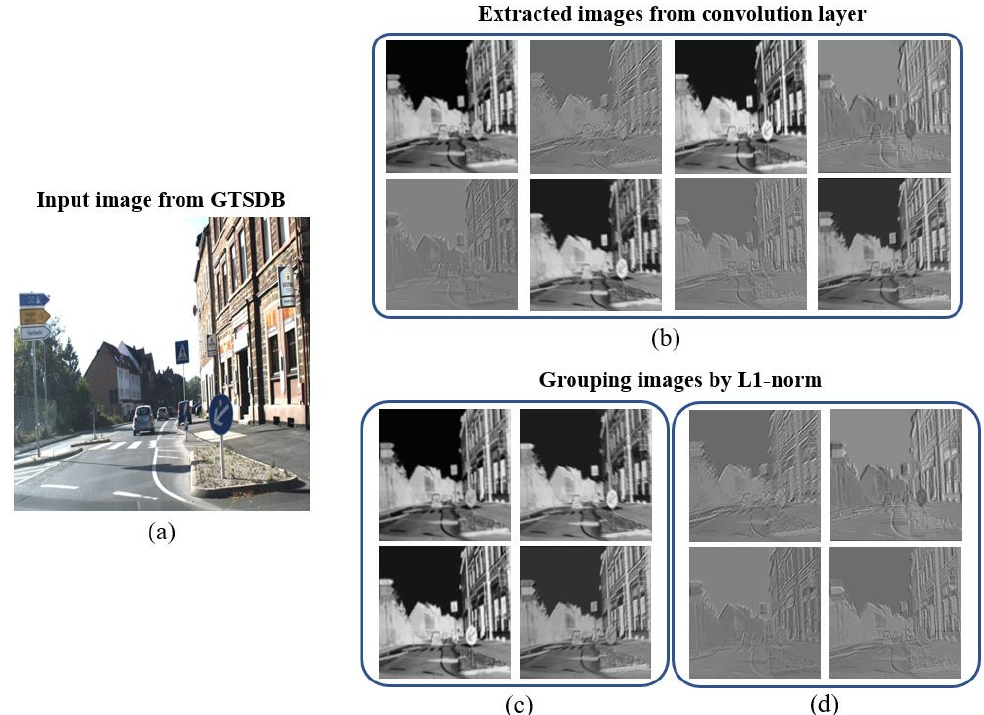
Figure 2. Examples of grouping images by similarity: ( a ) original input image from the GTSDB dataset; ( b ) extracted feature maps from the convolution layer; ( c ) grouping feature maps by focusing on the blue traffic sign; ( d ) grouping the remaining feature maps from ( b